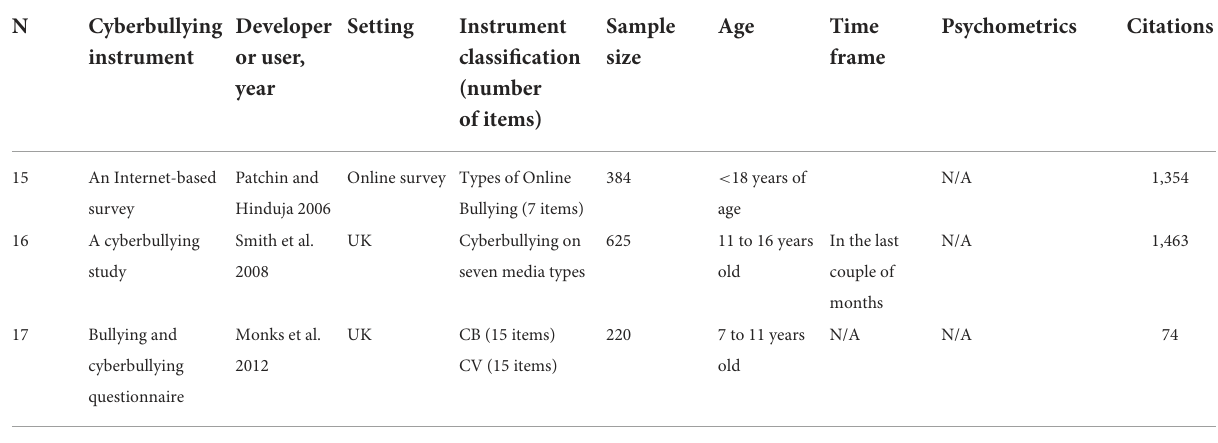
TABLE 2 The geographical distribution of respondents’ locations in the reviewed